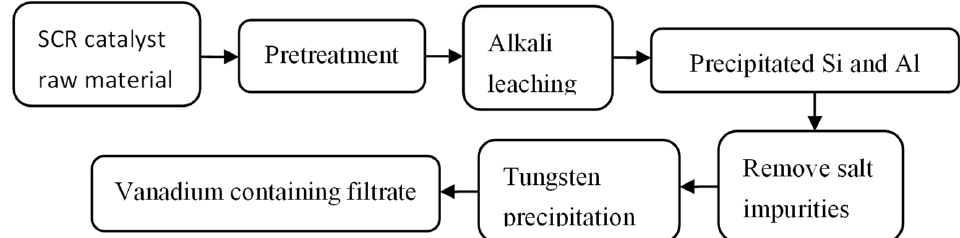
Figure 5. Process route for preparing vanadium-containing liquid from waste denitration catalyst.